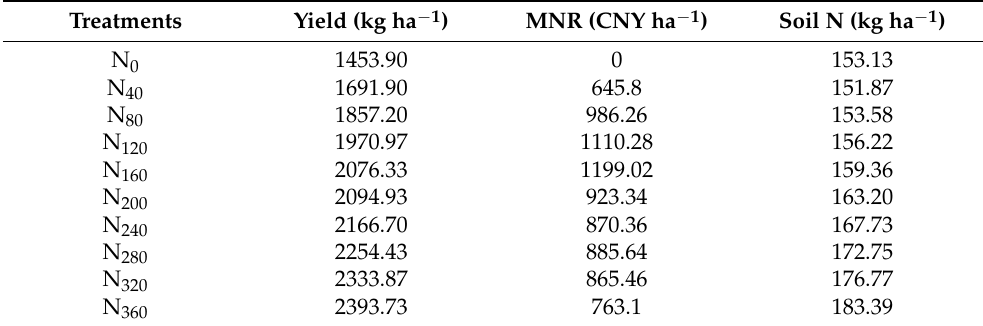
Table 5. Yield, marginal net return (MNR) of winter rapeseed and soil N under different nitrogen rates. The values are mean of 30 seasons.